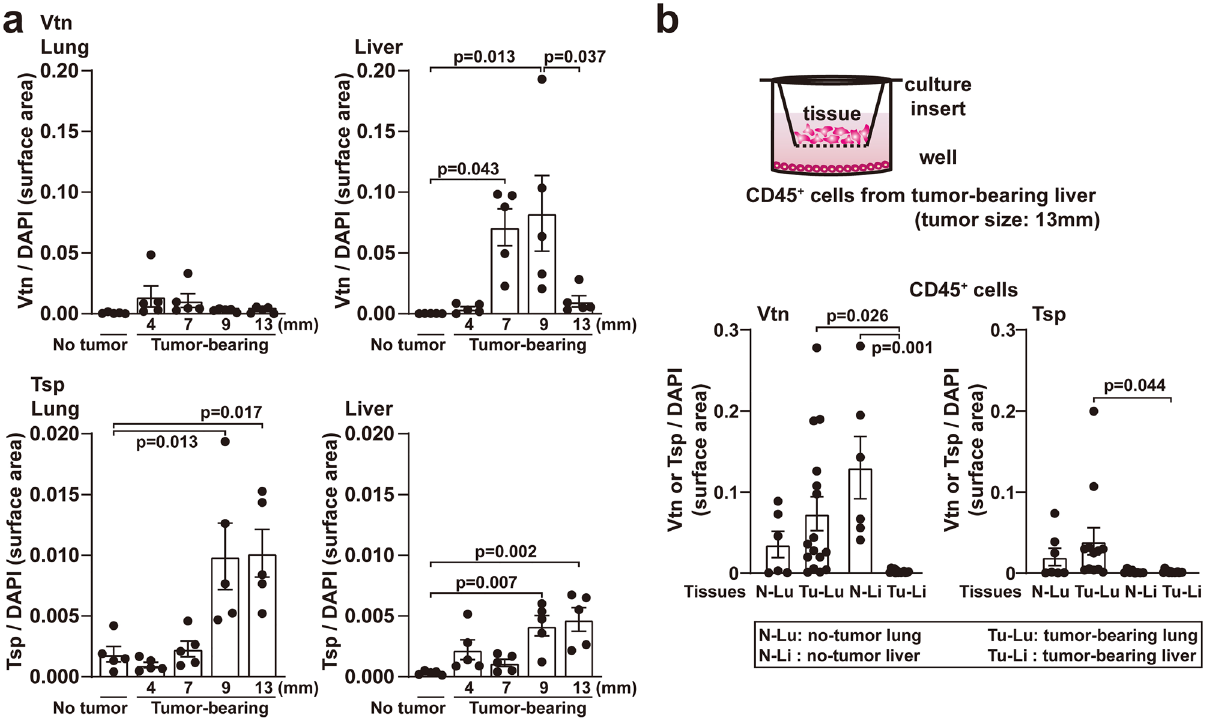
Figure 1. Vitronectin and thrombospondin 1 expression in tumor-bearing lungs and liver. ( a ) Unique expression of vitronectin (Vtn) and increase of thrombospondin 1 (Tsp) in tumor-bearing liver and lungs, respectively. Protein levels were examined immunohistochemically and normalized with DAPI. Tumor sizes which were the average of vertical and horizontal length in the maximum transverse section, are demonstrated in the graph. N = 4–5. ( b ) In vitro assay system for CD45 + cells from tumor-bearing livers cultured with conditioned media (CM), with organ tissues in separate culture inserts. The protein expression levels were evaluated immunohistochemically and normalized with DAPI. CM was derived from tumor-free lung (N-Lu), tumor-free liver (N-Li), tumor-bearing lung (Tu-Lu), or tumor-bearing liver (Tu-Li) cultures. Primary tumor diameter: 13 mm. N = 3–7 (2 tissue lobes in each mouse). Error bars indicate mean ± SEM, and P values are indicated in graphs ( a , b